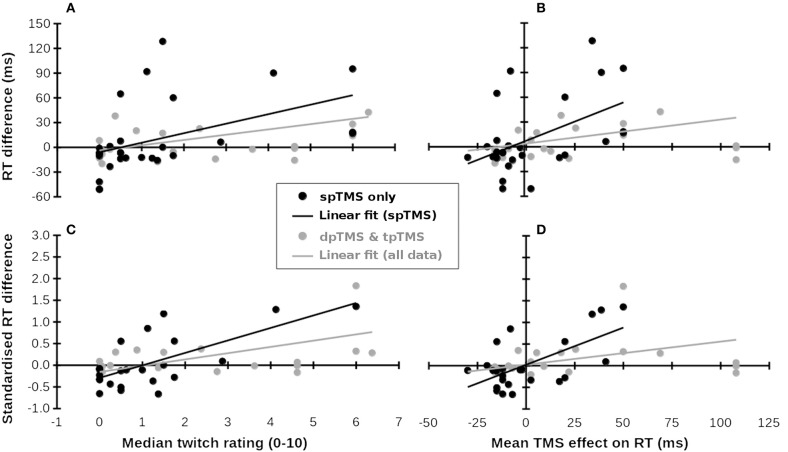
Subjective ratings of muscle twitches and TMS-related RT increases (x-axes, from Meteyard and Holmes, 2018) predict RT differences in published studies (y-axes, multiple studies). (A–D) Show different measures. Black symbols and lines: single-pulse TMS data; Gray symbols: Double- (dp) and triple-pulse (tp) TMS data. Gray lines: Linear fit across all available data. Data for the x-coordinates were taken from Meteyard and Holmes (2018). Data for the y-coordinates were taken from Baldassarre et al. (2016), Busan et al. (2009a,b,c); Busan et al. (2012), Cattaneo et al. (2009, 2014), Chica et al. (2011), Fautrelle et al. (2013), Jackson et al. (2015), Johnson et al. (2012), Kehrer et al. (2015), Koch et al. (2008), Ku et al. (2015), Machizawa et al. (2010), Newman-Norlund et al. (2010), Oshio et al. (2010), Pasalar et al. (2010), Renzi et al. (2011), Ricci et al. (2012), Salillas et al. (2009, 2012), Schuhmann et al. (2009), Shinshi et al. (2015), Teige et al. (2018), Tunik et al. (2008), Vernet et al. (2008), Wheat et al. (2013), and Yan et al. (2016). (A) Median twitch ratings (x-axis) predict raw RT differences (y-axis). (B) Mean TMS effect on RT predicts raw RT differences. (C) Median twitch ratings (x-axis) predict standardized RT differences (y-axis). (D) Mean TMS effect on RT predicts standardized RT differences.